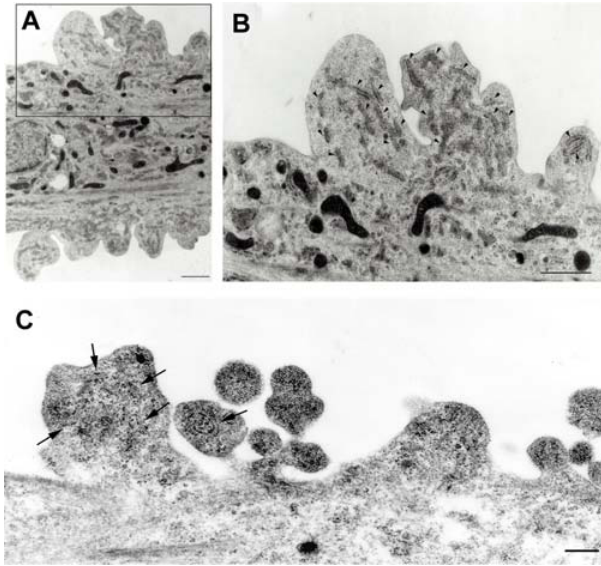
Figure 4. ER and SOD1 co-localization in peri-cytoplasmic membrane region. ( A ) Electron micrograph of L84V SOD1-expressing SK-N-SH cells after treatment with 1 m g/ml of tunicamycin for 24 h as described in Materials and Methods. ( B ) Enlargement of part of ( A ). Arrowheads indicate abnormal ER aggregates, where mutant SOD1 is localized as in Fig. 3C 9 and 3E 9 . Scale bar=1 m m. ( C ) SOD1 localization in peri- cytoplasmic membrane region. Cells were treated as described in ( A ) and immune electron micrograph was obtained as described in Materials and Methods. Arrows show SOD1 immunoreactive in ER.